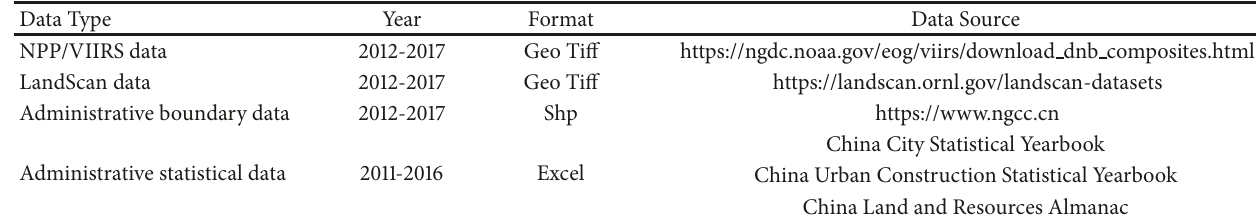
Table 1: The datasets used in the study (by format and